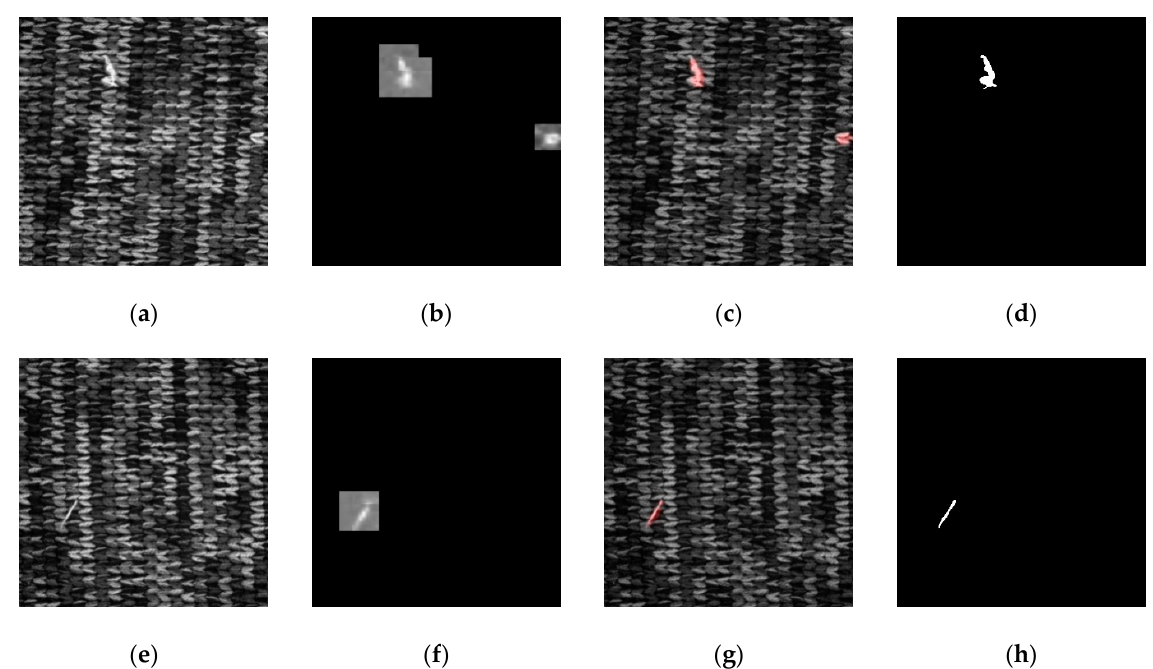
Figure 4. Fabric A network prediction result: ( a , e ) original image; ( b , f ) prediction result by segmenting the map with the sliding window; ( c , g ) network prediction confidence map, which is obtained by segmenting ( b ) and ( f ) through a binary process; the red pixels are the defect areas determined on the network; ( d , h ) defect annotation map.